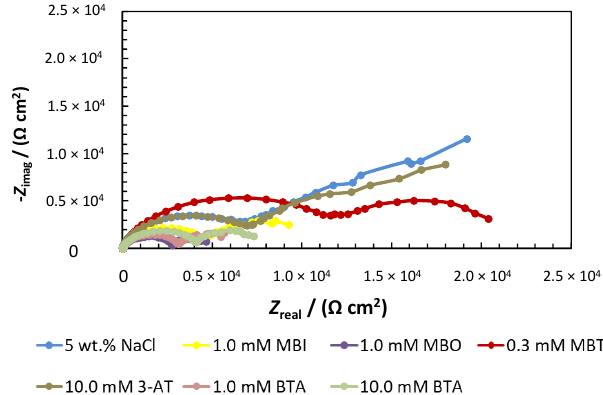
Figure 2. The Nyquist plots of the AA6082 aluminium alloy samples immersed at 50 °C in 5 wt.% NaCl solution containing different concentrations of five azole compounds.